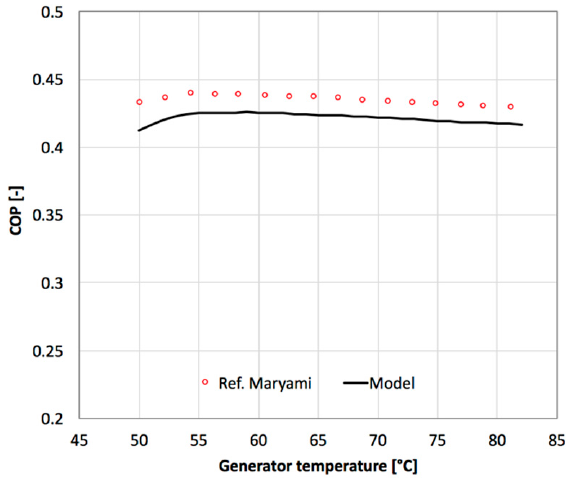
Figure 4. Chiller performance (COP) under various generator temperature: the comparison between the numerical results and the reference data in [39].